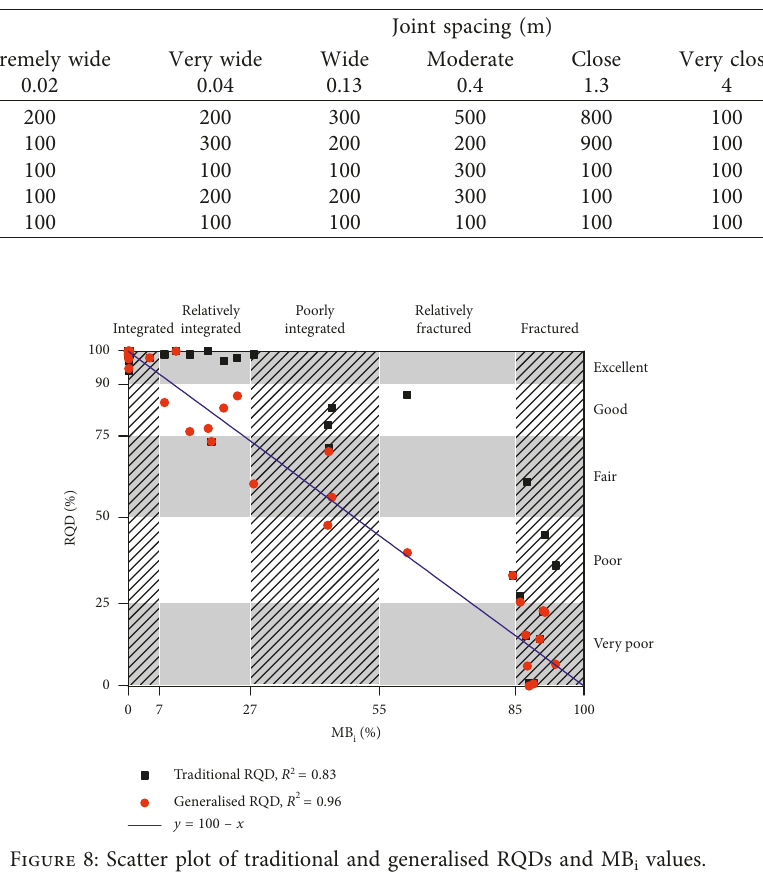
Table 8: Optimal thresholds of all hypothetical models.